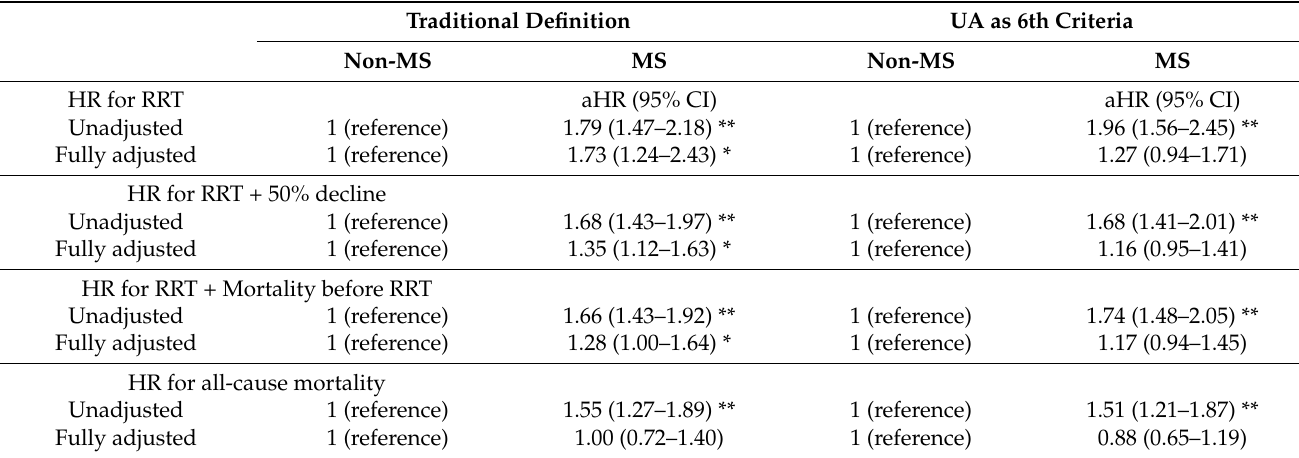
Table 5. HR of MS for clinical outcomes by tradition definition or adding UA in the